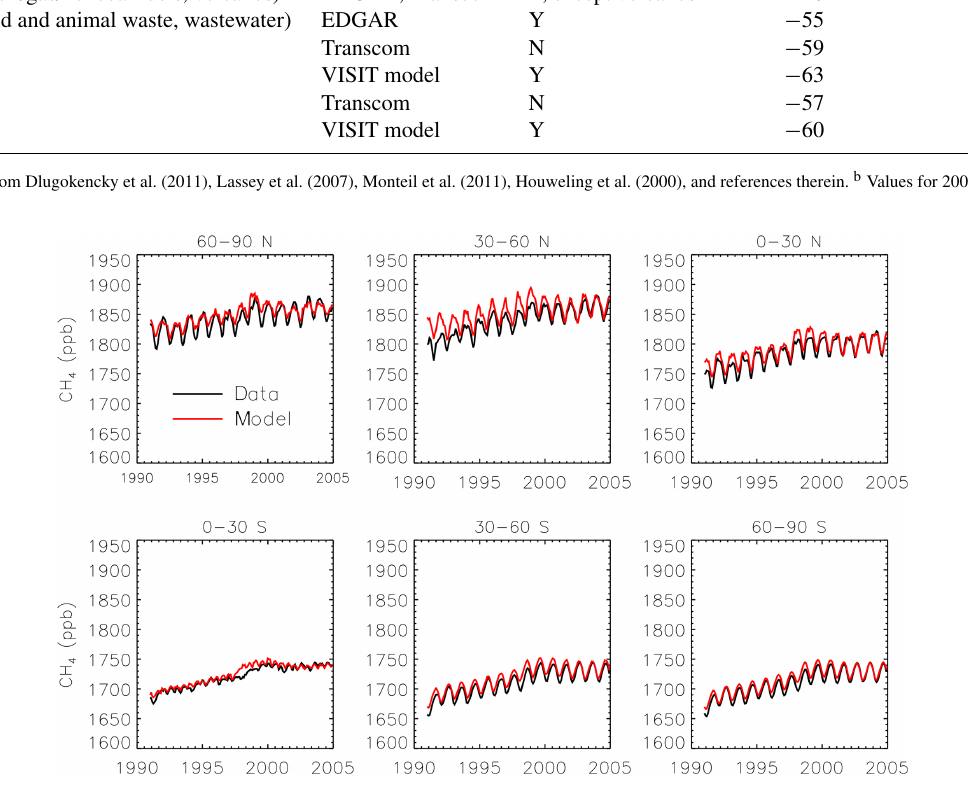
Figure 1. Monthly CH 4 observations from the GMD network (black) and simulated surface concentrations from SimStd (red) averaged over latitude